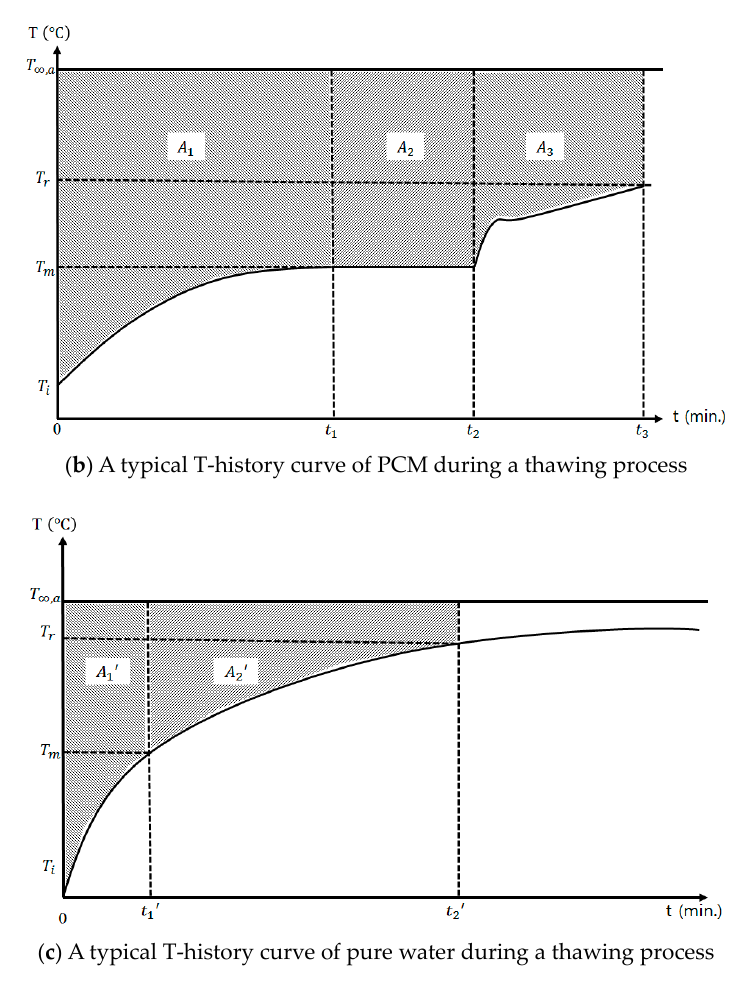
Figure 3. Time ‐ temperature graph for applying the T ‐ history method of PCM and pure water. Figure 3. Time-temperature graph for applying the T-history method of PCM and pure